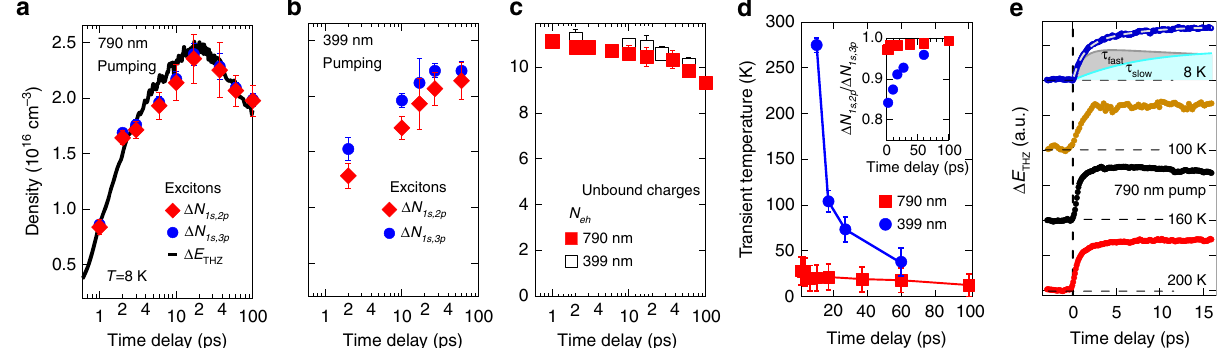
Figure 4 | The time-evolution of the exciton distribution distinguishing various processes. ( a , b ) Exciton population difference D N 1 s ,2 p (red diamonds), D N 1 s ,3 p (blue dots) as a function of time delay in a logarithmic scale at 8K for 790nm (550 m Jcm (cid:2) 2 ) and 399nm (120 m Jcm (cid:2) 2 ) excitation, respectively. The detailed THz time scan with 50fs resolution is shown together in a . The error bars of carrier densities indicate the uncertainty from theoretical fitting of the experimental results. ( c ) The time-dependent density N eh of unbound carriers for two pumping conditions. ( d ) Time-dependent ratios of the population difference D N 1 s ,2 p / D N 1 s ,3 p are shown in the inset, which allows to extract the cooling curves for two pumping conditions. ( e ) The photoinduced THz transmission under 790nm and 550 m Jcm (cid:2) 2 pumping for various temperatures. A two-step rise, t fast B 1.0 ± 0.03ps (grey) and t slow B 11.2 ± 1.06ps (cyan) is separated for the 8K and (2) the resonant scattering of 1 s exciton with The distinct rise times of the relatively cold 1 s exciton finite momentum distribution with discrete THz phonon populations associated with the below-resonance pumping modes B 1 – B 4 in CH 3 NH 3 PbI 3 . Initially the formation of underpin a formation pathway different from the cooling of incoherent 1 s exciton populations occurs on a timescale high-energy carriers. The time-dependent exciton density faith- determined by the quantum dephasing time that characterizes fully follows the detailed THz time scan with 50 fs resolution the optical coherence-to-population conversion arising from (black line, Fig. 4a) under 790 nm pumping, which displays a multiple scattering contributions and disorder effects. The two-step rise with characteristic times t fast B 1.0 ± 0.03 ps and t slow B 11.2 ± 1.06 ps at 8 K (blue dots, Fig. 4e). We attribute linewidths of the observed resonant internal THz transitions this two-step exciton buildup to (1) the loss of exciton coherence indicate optical polarization dephasing times of the order of 1 ps,